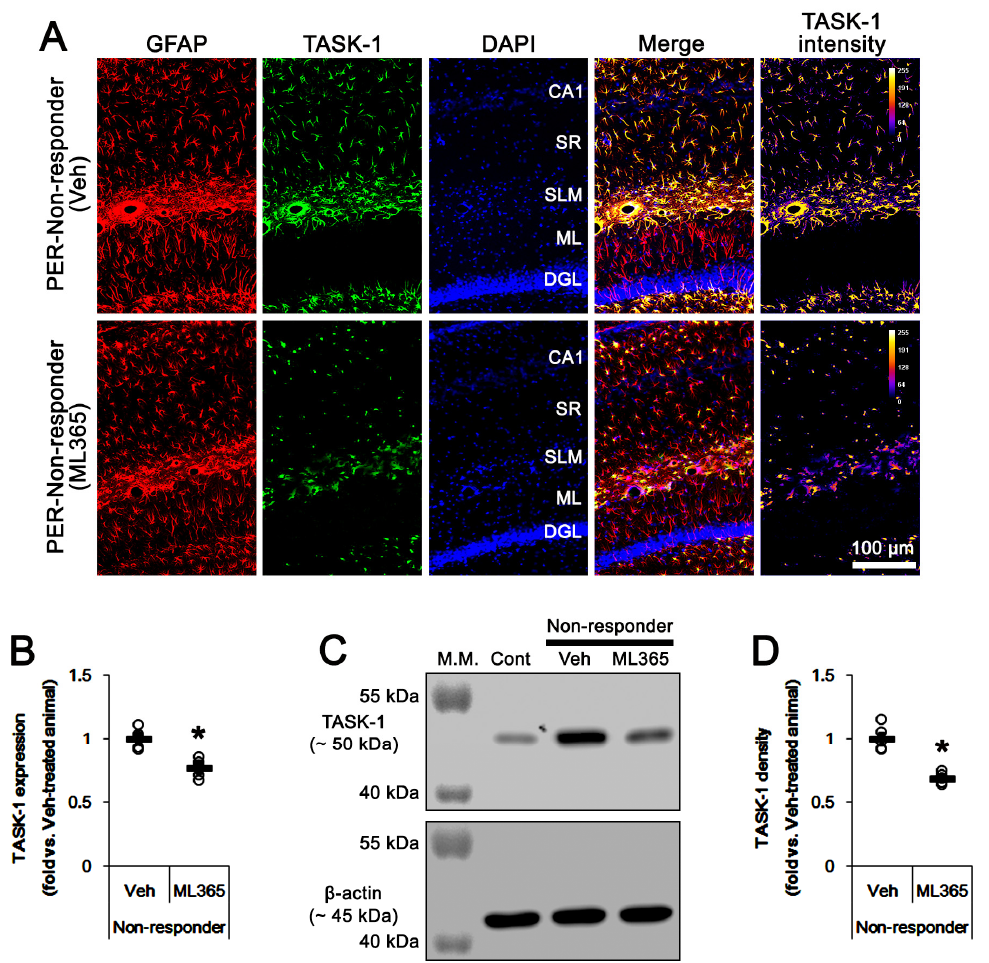
Figure 6. The effect of ML365 on TASK-1 expression in non-responders to perampanel (PER). As compared to vehicle (Veh), ML365 reduces TASK-1 expression in CA1 astrocytes within the hippo- campus of non-responders. ( A ) Representative photos of TASK-1 expression in the hippocampus (CA1, CA1 pyramidal cell layer; SR, stratum radiatum; SLM, stratum lacunosum-moleculare; ML, molecular layer of the dentate gyrus; DGL, dentate granule cell layer). ( B ) Quantitative analyses of the effect of ML365 on TASK-1 expression based on immunofluorescence data. Open circles indicate each individual value. Horizontal bars indicate the mean value. Error bars indicate SEM (* p < 0.05 vs. vehicle-treated animals). ( C ) Representative Western blot images of TASK-1 protein expression in the hippocampal tissues. ( D ) Quantifications of TASK-1 level based on Western blot (* p < 0.05 vs. vehicle-treated animals). 2.4. Effect of ML365 Co-Treatment on Refractory Seizures in Non-Responders to PER Since PER and ML365 effectively reduced TASK-1 expression in CA1 astrocytes (Fig- ures 4 and 6), it is likely that upregulated TASK-1 function/expression in CA1 astrocytes would reduce the efficacy of PER in chronic epilepsy rats. Therefore, we evaluated the effects of ML365 co-treatment on intractable seizures in non-responders to PER. In non- responders to PER ( n = 5), total seizure frequency, total EEG seizure duration and average seizure severity were 16.6 ± 2.1, 616 ± 51 s and 3.3 ± 0.2 over the 1-week period, respectively (Figure 7A–C). ML365 co-treatment gradually reduced seizure frequency ( χ 2(7) = 17.5, p =